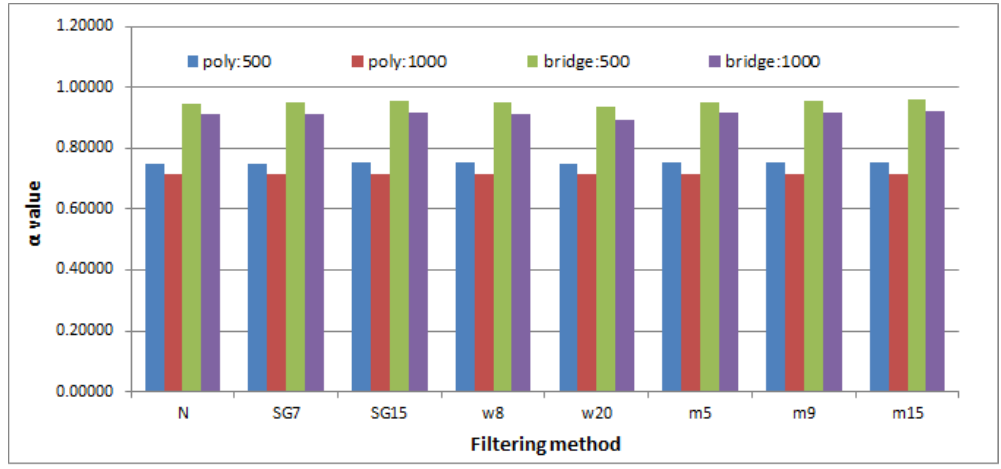
Figure 7. The α values averaged over all time series independently for different smoothing methods and detrended fluctuation analysis (DFA) method